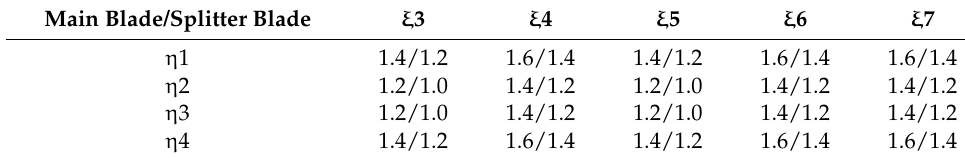
Table 6. Value of weight of each control point.